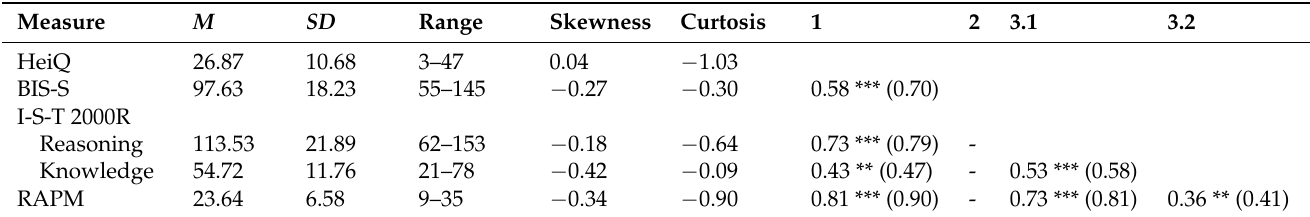
Table A2. Descriptive statistics and correlations of all